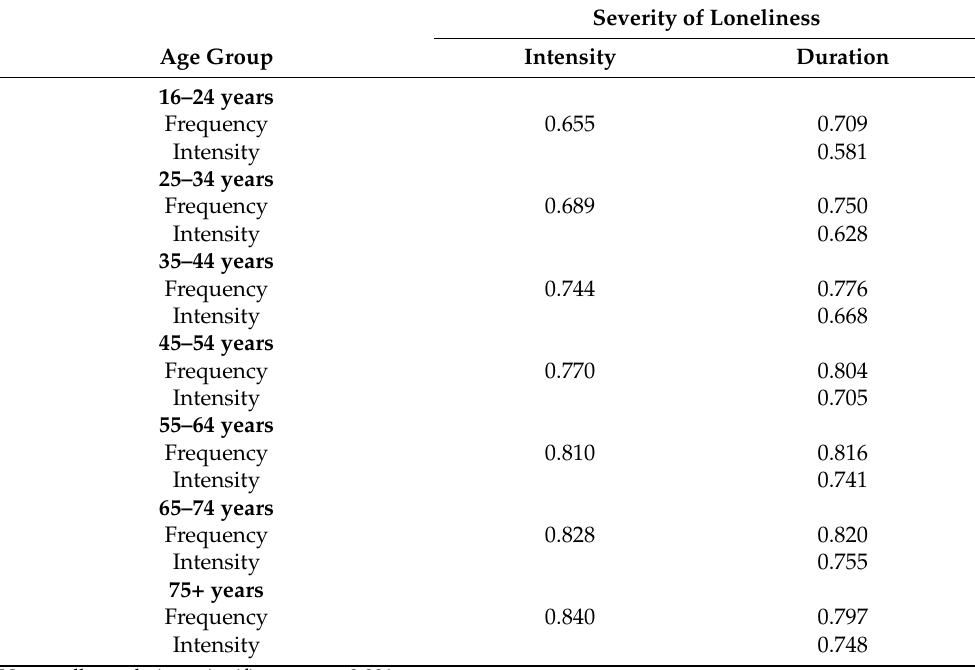
Table 3. Correlations (by age) between the three different aspects of severity of